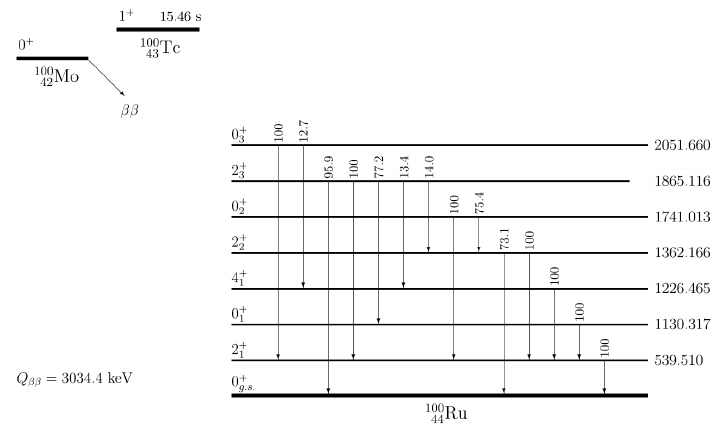
Figure 1. Scheme of 2 β − decay of 100 Mo to the ground state and to the first excited levels of 100 Ru (reprinted from Reference [21] with permission from Elsevier). The energies of the levels and the relative main branching ratios are taken from Reference [22].